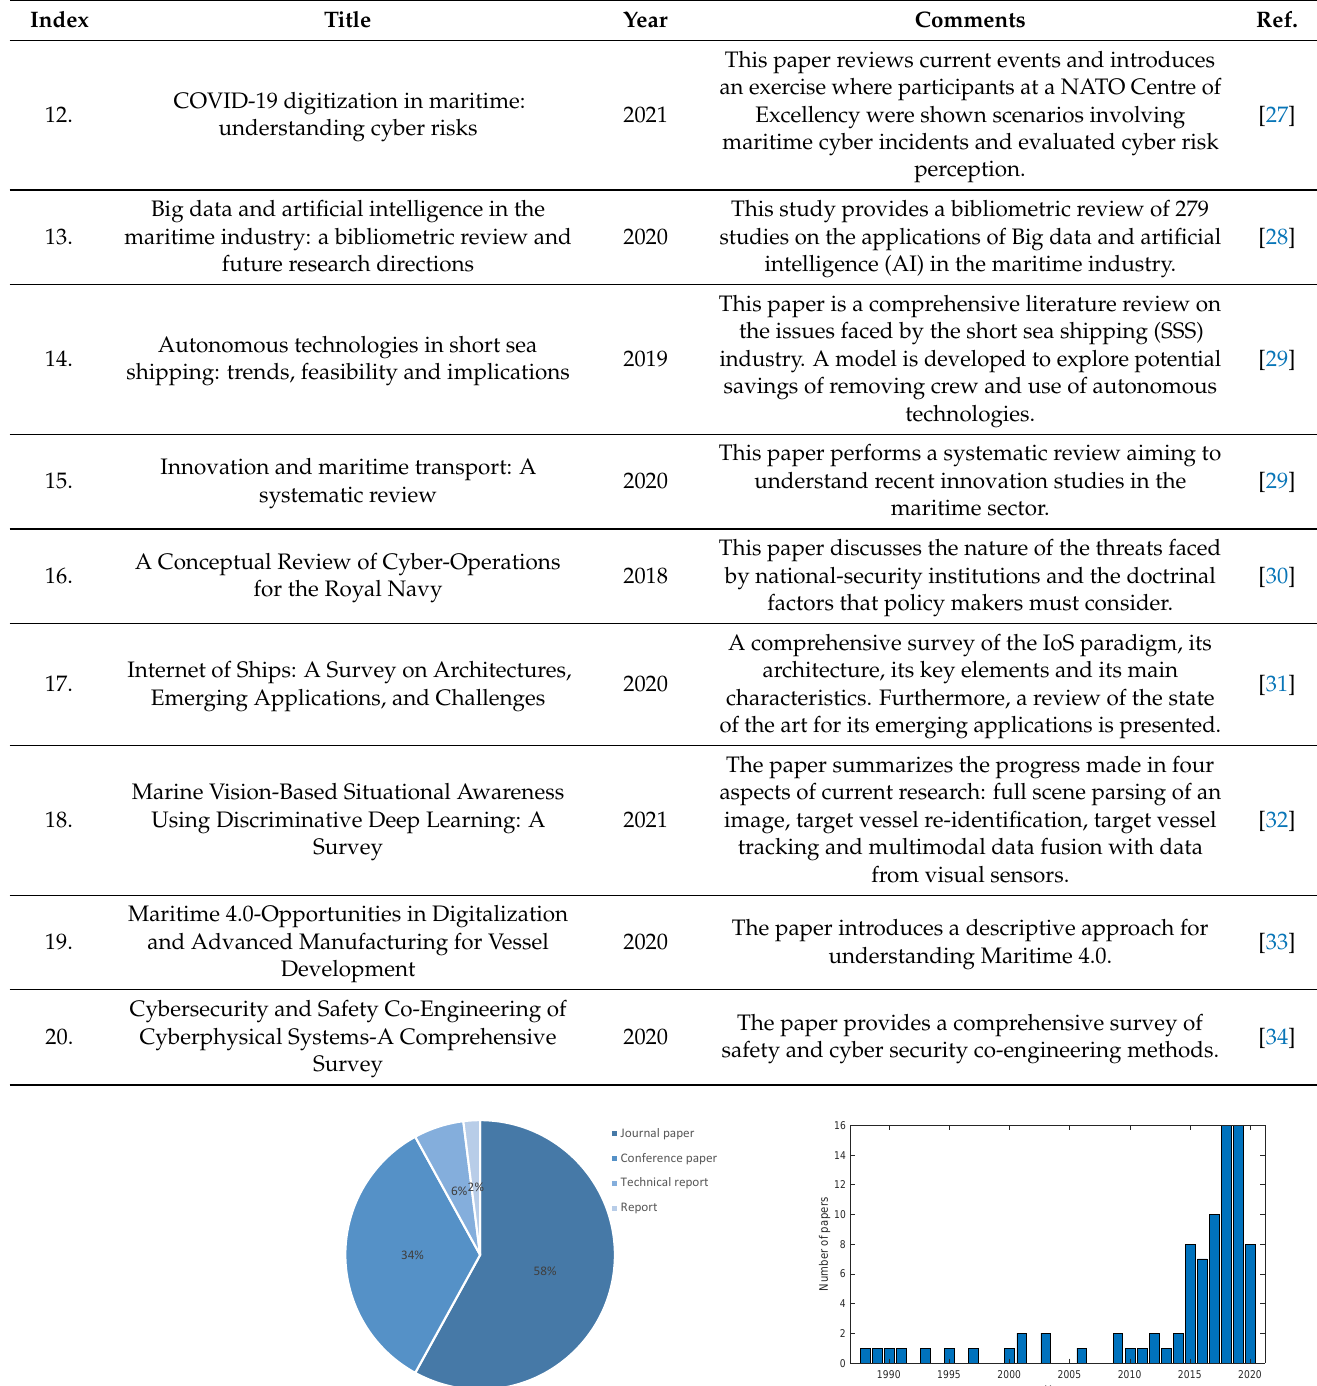
Figure 1. Classification of the reviewed